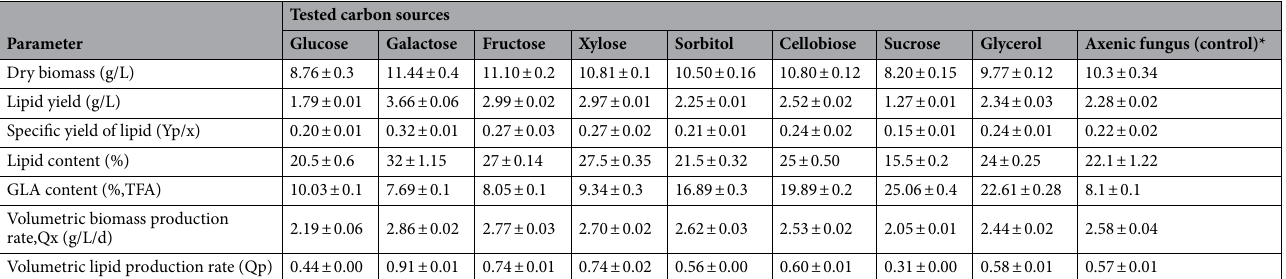
Table 1. Influence of different carbon sources on dry biomass, GLA, and lipid production parameters by coculture fermentation. *Axenic fungus cultured on K&R medium containing glucose as a carbon source and ammonium tartrate as a nitrogen source at a pH 6.0 and 28 °C for 4